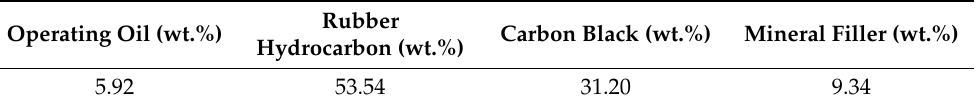
Table 2. Component of WTCR.